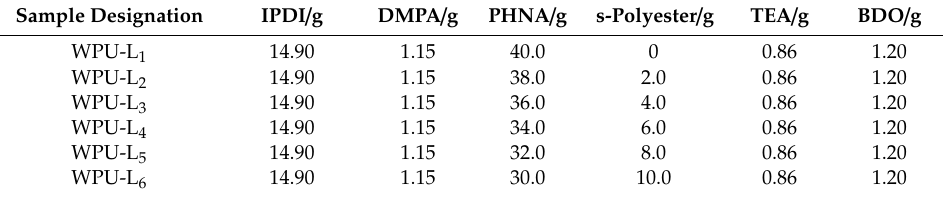
Table 2. The formulation of large-particle waterborne polyurethane (WPU-L).